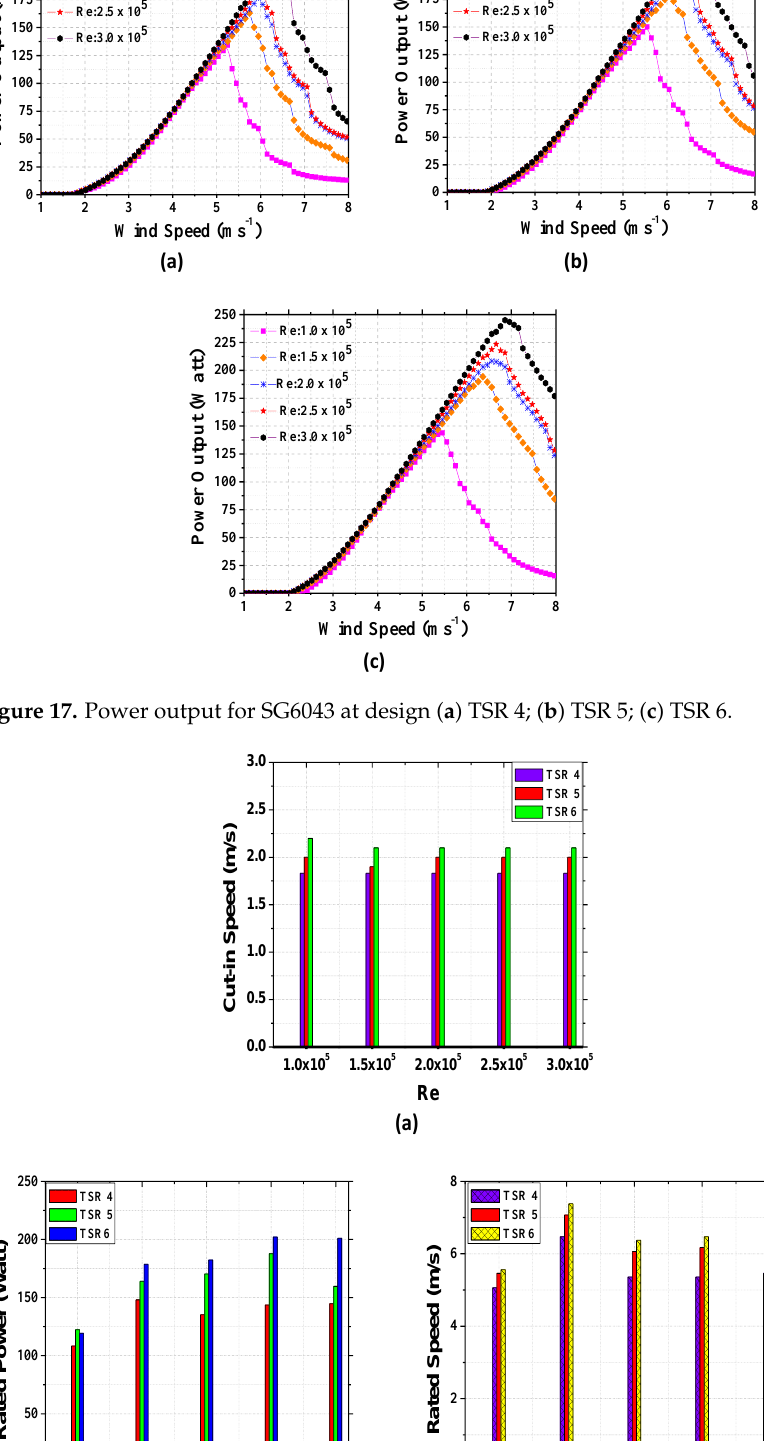
Figure 16. Power output for NACA 4412 at design ( a ) TSR 4; ( b ) TSR 5; ( c ) TSR 6.